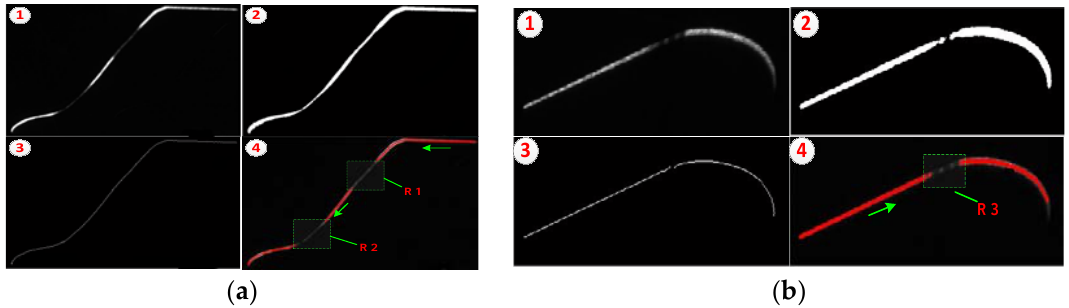
Figure 9. Location of stripe segments that are to be enhanced. ( a ) Images captured by the outer camera, ( b ) inner images. ① is the original image, ② shows the segmented and binarized image, ③ presents the stripe skeleton, and ④ indicates the regions established through stripe quality evaluation.